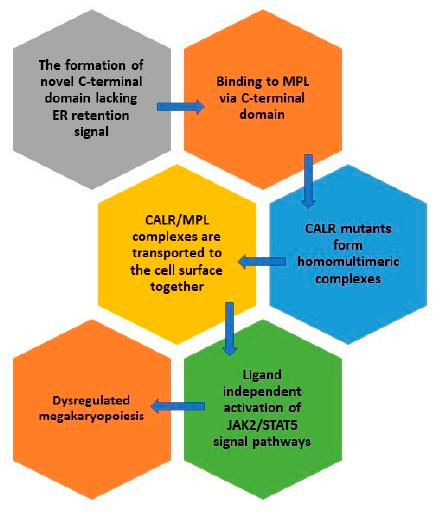
Figure 2. The pathogenic effects of CALR